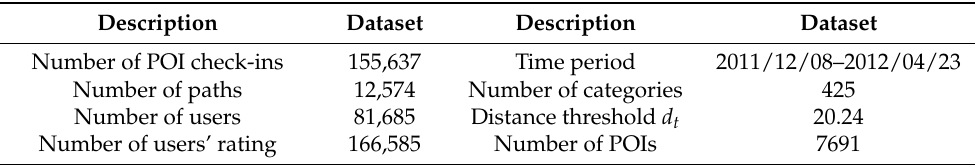
Table 5. Foursquare